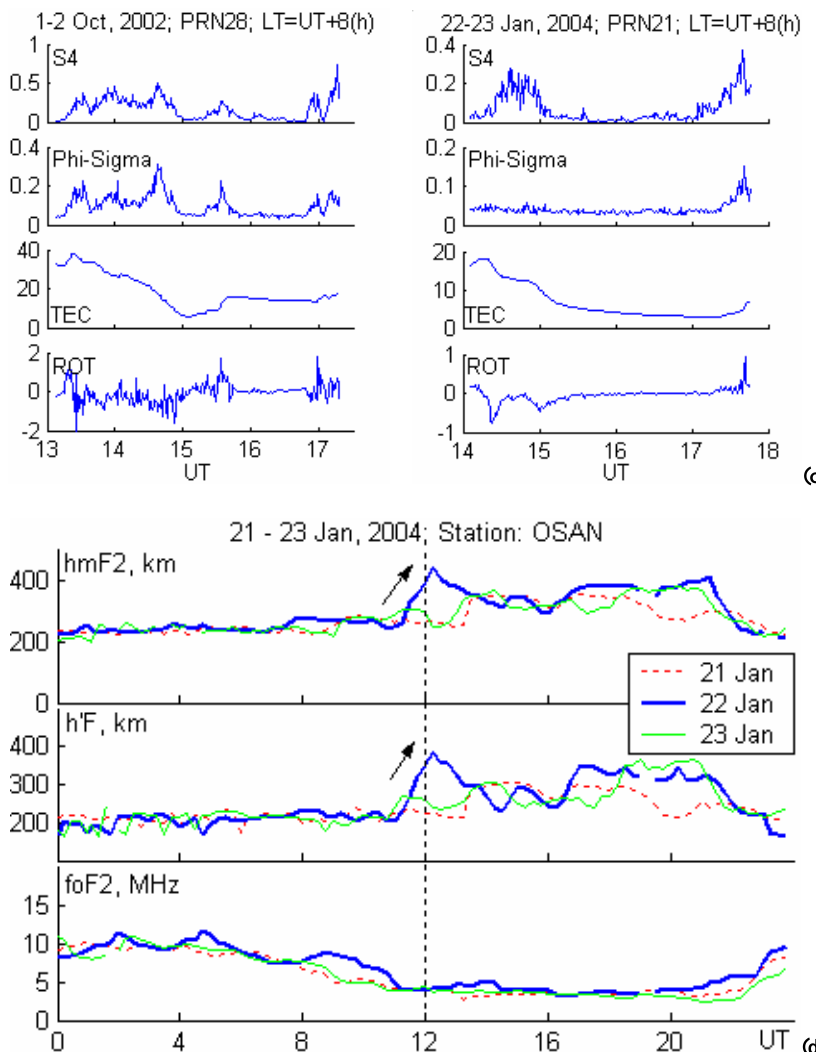
Fig. 3. Continued. (c) Plots at every 1-min interval of (1) S4 index (2) Phi-Sigma index (3) TEC (4) rate of TEC (ROT) for PRN 28 Figure. 3d. Increases in hmF2 and h ' F observed at OSAN (37.1 ° N, 127.0 ° E ) on 22 January, 2004 provide an evidence of uplift of F layer (Data obtained from SAO database).